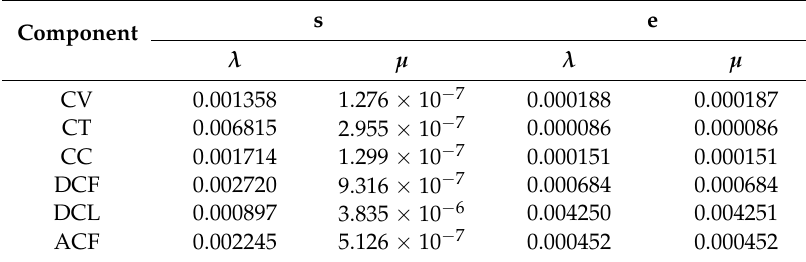
Table 6. Sensitivity analysis of reliability parameters to energy availability.